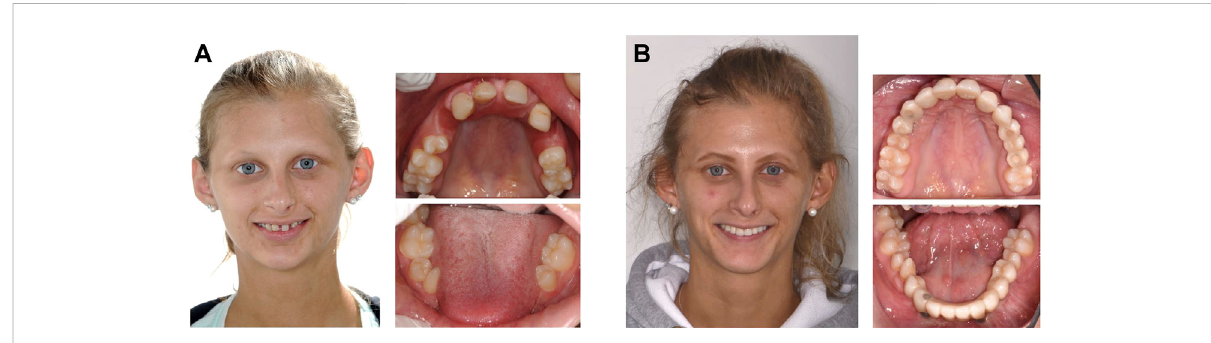
FIGURE 2 Oral rehabilitation in a woman with ectodermal dysplasia missing 14 permanent teeth. (A) , affected female adolescent before multidisciplinary dental treatment. (B) , results of prostodontic rehabilitation. (Photos: Prof. Dr. Stephan Eitner, Department of Prosthodontics, and Dr. Dr. Ines Willershausen, Department of Orthodontics and Orofacial Orthopedics, University Hospital